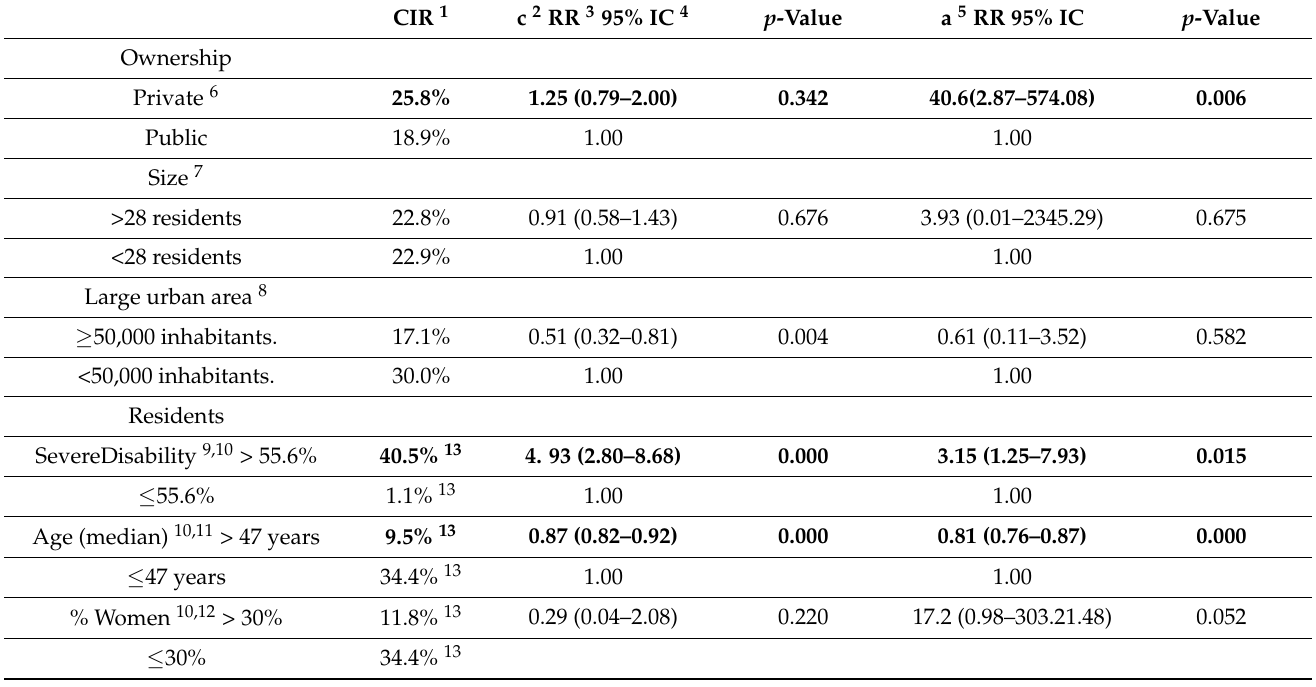
Table 3. Risk factor of COVID-19 incidence in long-term care residential homes for patients with